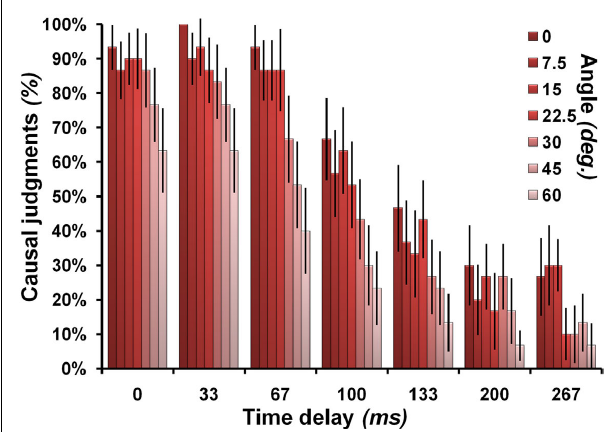
FIGURE 2 | Causal judgments in relation to stimulus characteristics. Illustrates the probability that a particular combination of angle and time delay was judged as causal. The angle manipulation is color-coded on a scale from dark red (no angle) to light red (60 ° ). The error bars represent the standard error of the